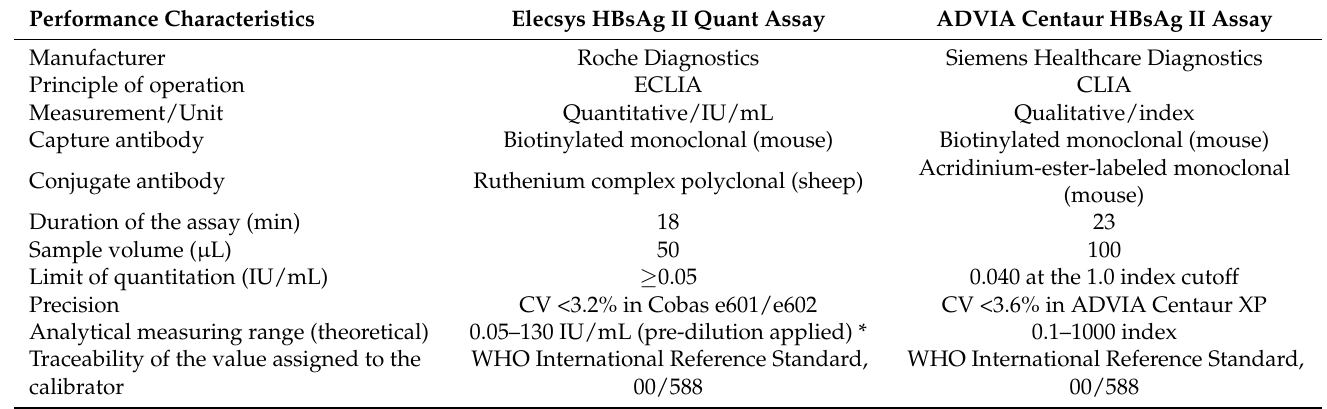
Table 1. Comparison of performance characteristics of two HBsAg assays provided by the